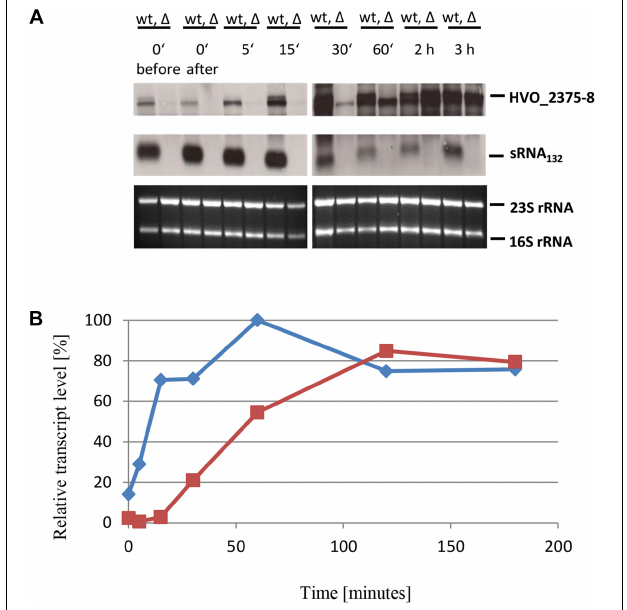
FIGURE 5 | Transcript levels of sRNA132 and the HVO_2375-2378 operon mRNA at different phosphate concentrations. The operon encodes a phosphate-specific ABC transporter. The wild-type H26 and the sRNA132 gene deletion mutant were grown in media with various phosphate concentrations, as indicated at the top. At mid exponential growth phase (about 5 × 10 8 cells ml − 1 ) aliquots were removed, RNA was isolated and used for Northern blot analyses with operon-specific and sRNA-specific probes, as indicated at the right. Ethidium bromide stained 23S and 16S rRNAs are shown at the bottom. The red boxes highlight phosphate concentrations at which the operon mRNA could only be detected in the presence of sRNA132.